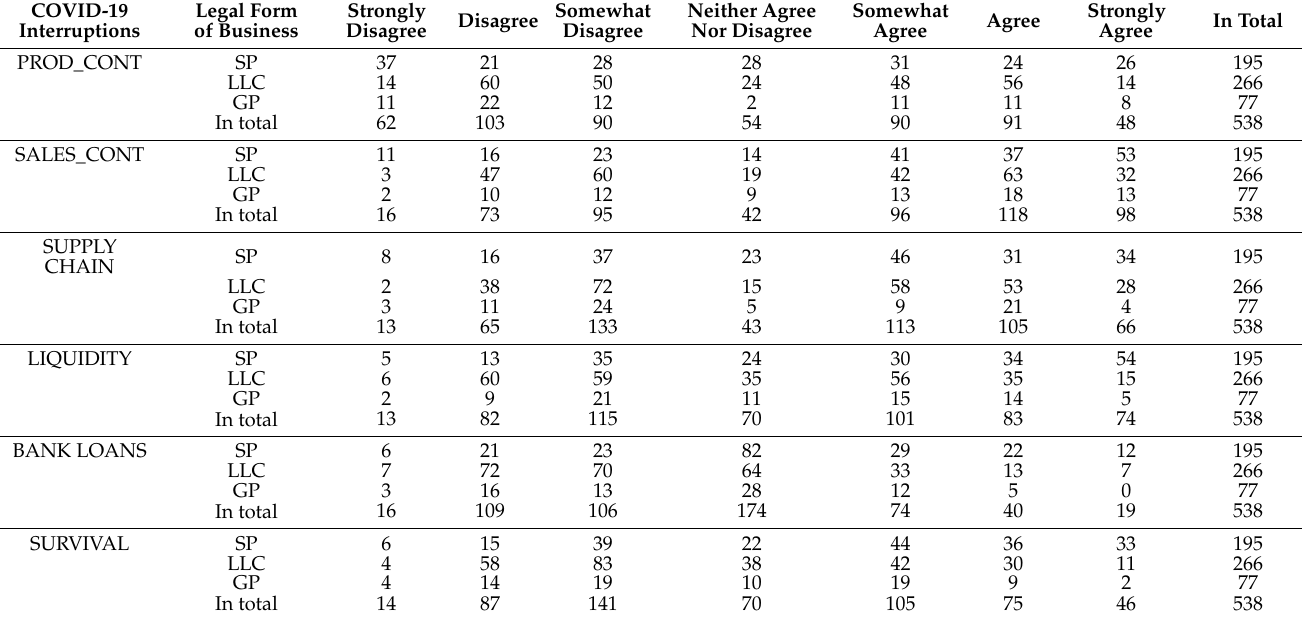
Table A3. Descriptive statistics of the COVID-19 interruptions by the type of the legal form of the business. SP LCC GP Mean